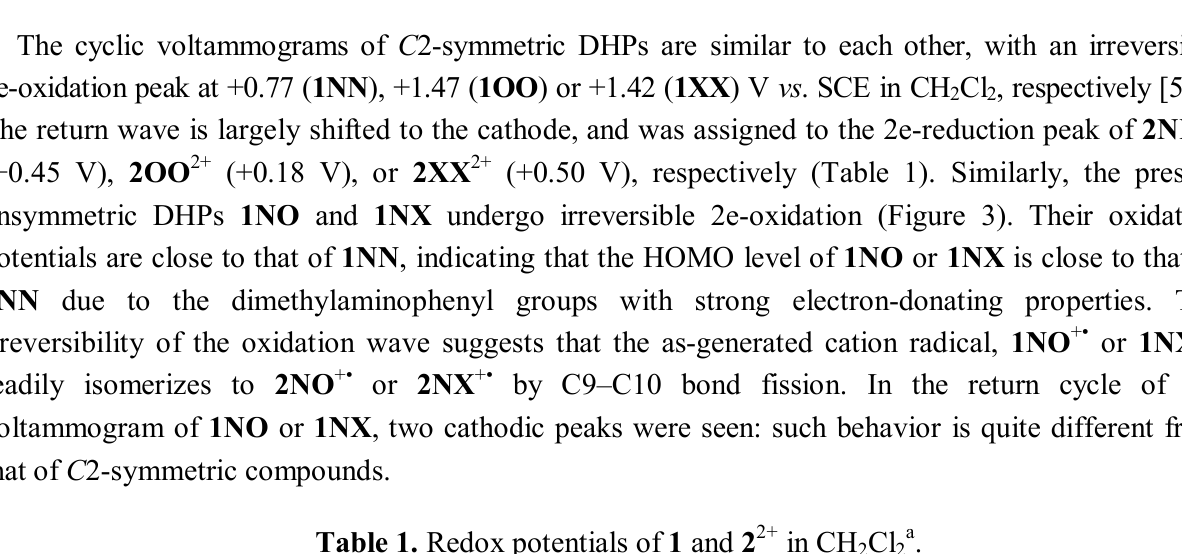
Table 1. Redox potentials of 1 and 2 2+ in CH